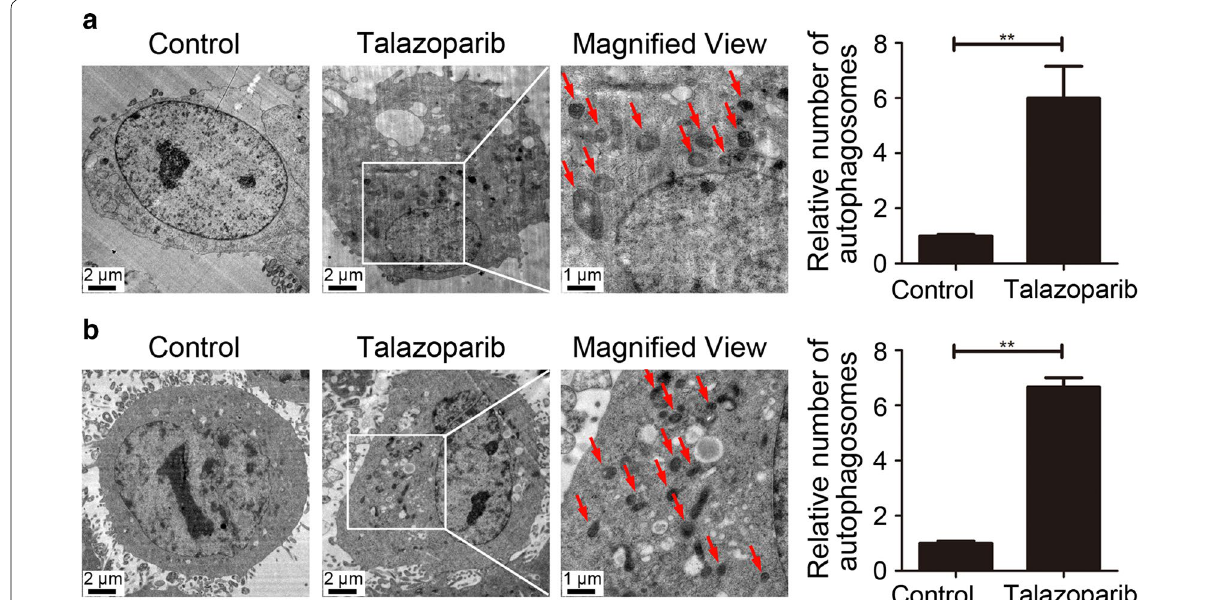
Fig. 2 Autophagosomes accumulation was induced by PARP inhibitor talazoparib in CML cells. Ultrastructural analysis of P#1 cells ( a ) and P#2 cells ( b ) treated with 20 μM of talazoparib for 48 h by TEM. The relative number of autophagosomes were quantified by Image J software ( N mean SD, ** P < 0.01) ±